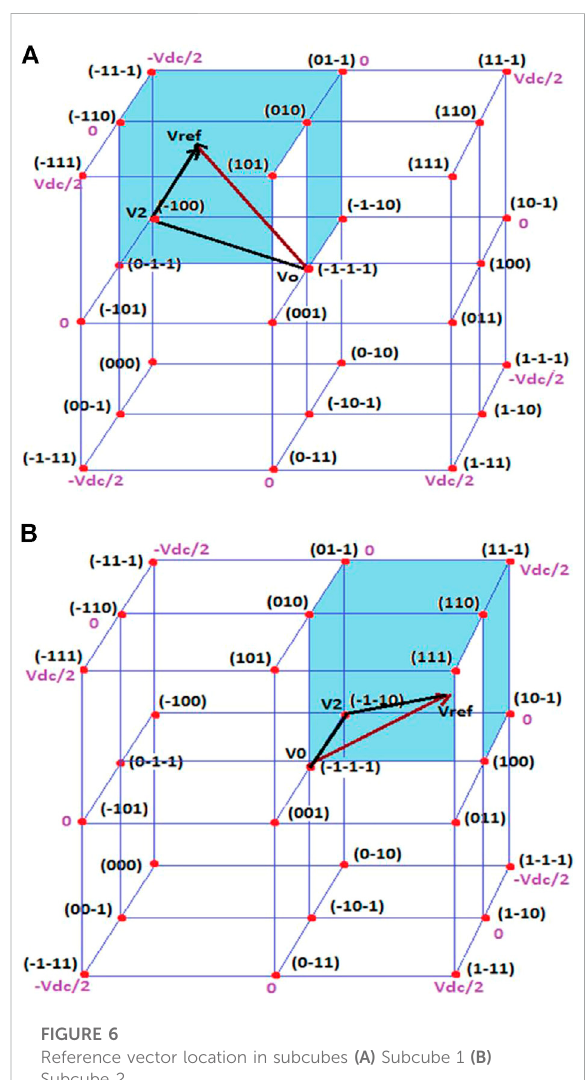
FIGURE 6 Reference vector location in subcubes (A) Subcube 1 (B) Subcube 2.